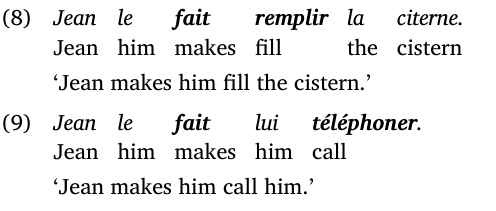
Figure 16: Anchored EPTD for the clitic pronoun se used as an object of a caused verb referring to the subject of the causative